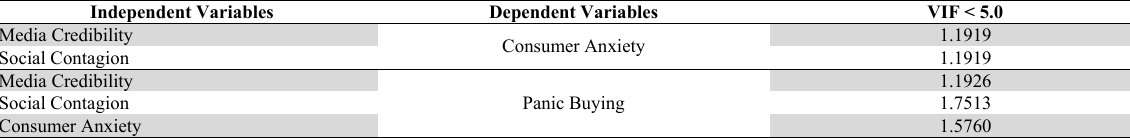
Inter-construct Multicollinearity Testing